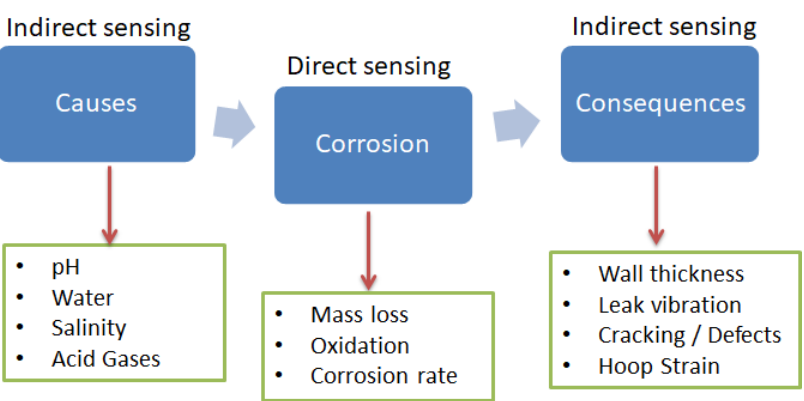
Figure 1. Categories of corrosion sensors and their characteristics with the causes and consequences.